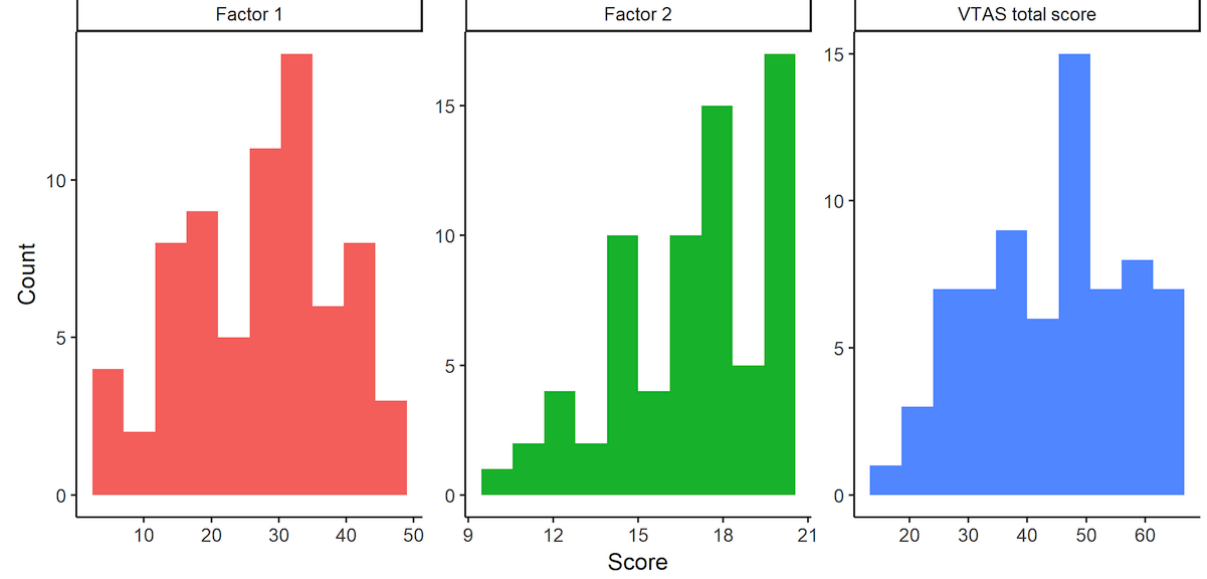
Figure 2. Histograms of the Virtual Therapist Alliance Scale (VTAS) total and subscale